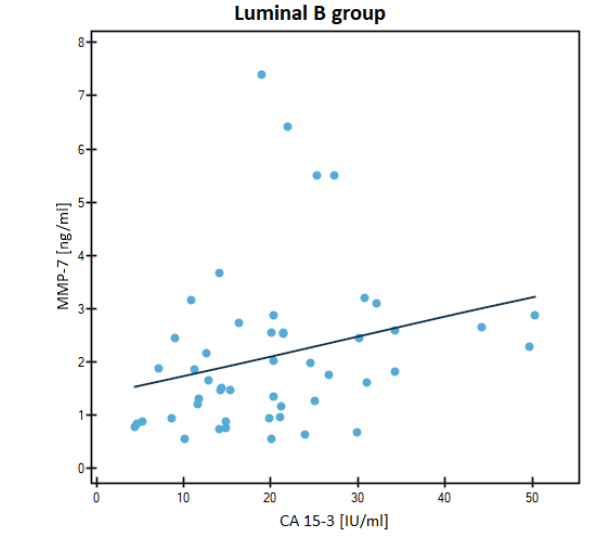
Figure 7. Significant correlations by Spearman’s method between MMP-7 and CA 15-3 in the entire study group and Luminal B HER2-negative subgroup.